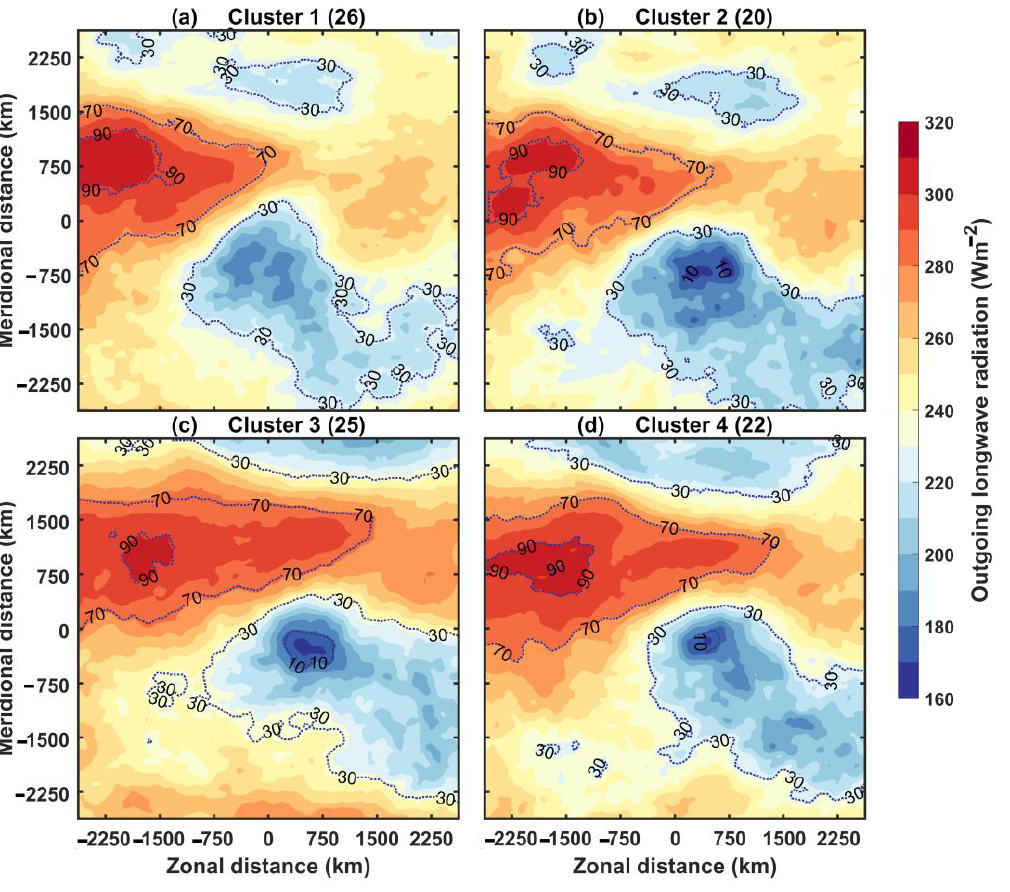
Figure 7. Composites of outgoing longwave radiation (OLR, Wm −2 ) for ( a ) Cluster-1, ( b ) Cluster-2, ( c ) Cluster-3, and ( d ) Cluster-4. The dotted contours represent percentile values. The value in the parenthesis represents the number of tropical cyclones obtained for each cluster.